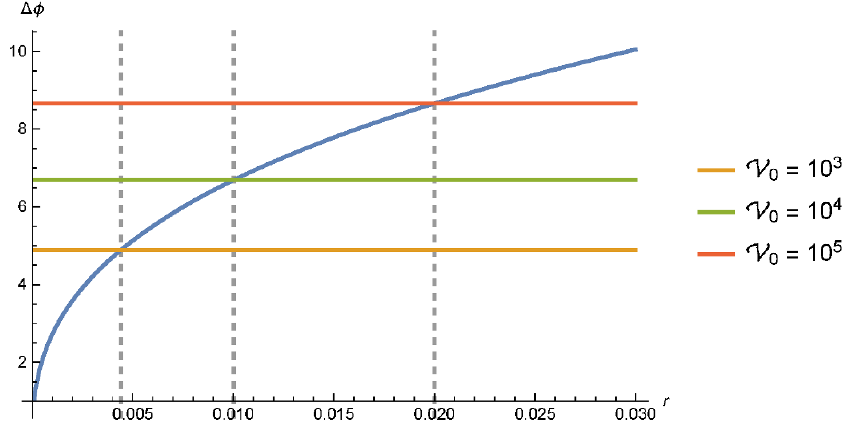
Figure 5 . In(cid:13)aton range (cid:1) (cid:30) in units of M p as a function of the tensor-to-scalar ratio r for in(cid:13)ationary potentials of the form (5.3), and corresponding upper bounds for g s = 0 : 3, N e = 50 and V = 10 3 , 10 4 and 10 5 0